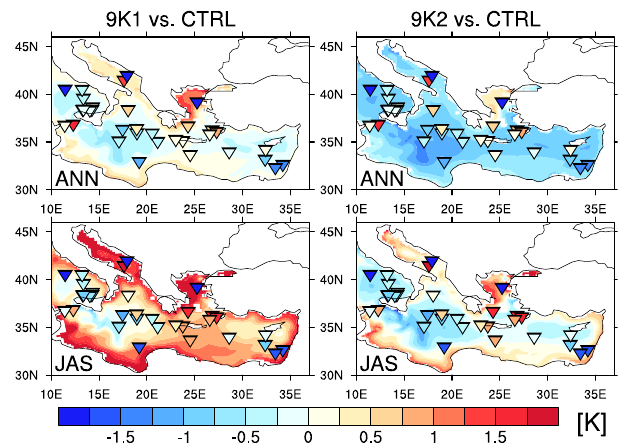
Fig. 21. Annual and summer (JAS) T 0 − 30 anomalies, calculated from SST reconstructions from proxy data (triangles, Kucera et al. (2011)) vs. modelled one (background colour) for 9K1 vs. CTRL (left) and 9K2 vs. CTRL (right). 1st row displays annual T 0 − 30 anomalies, 2nd row displays summer T 0 − 30